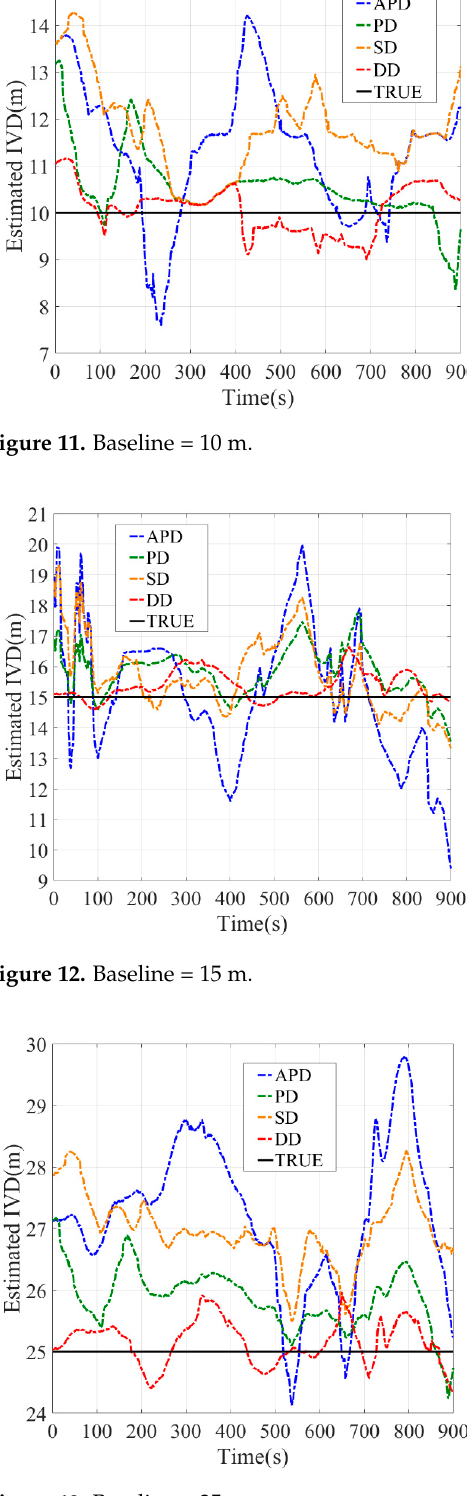
Figure 13. Baseline = 25 m.